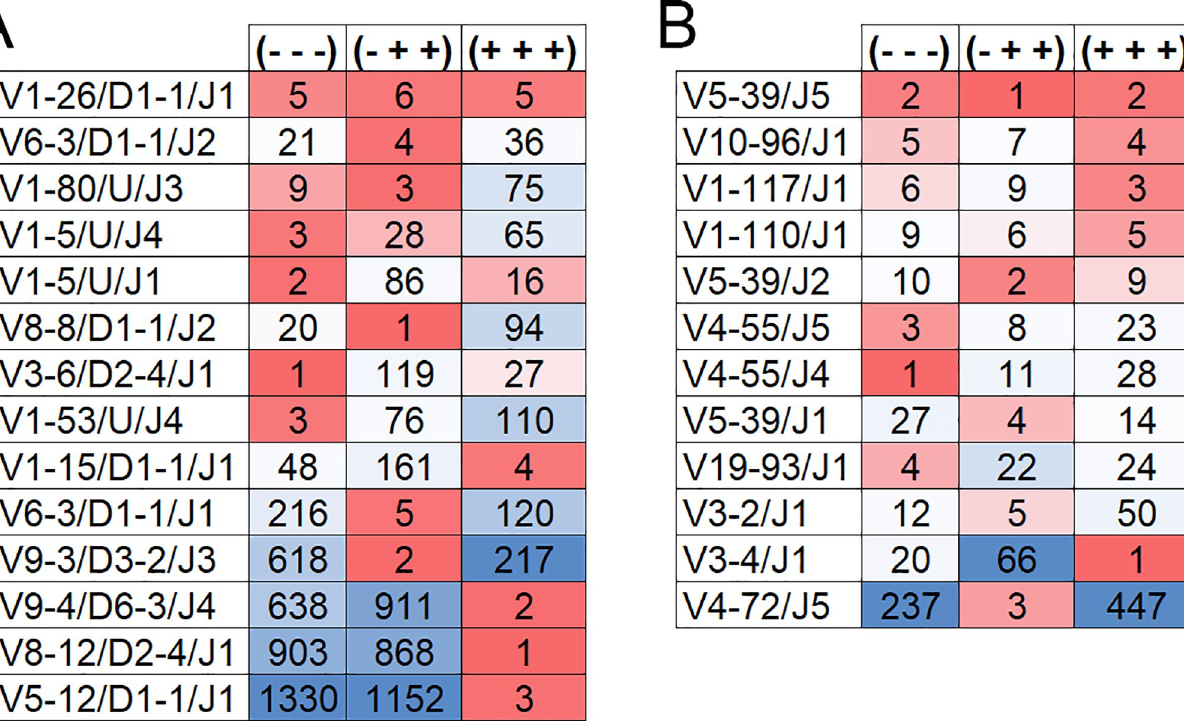
Fig 8. Ranking of High Frequency V-/D-/J-Gene Segment Combinations for Heavy Chain (A) and V-/J-kappa (B) Chain. Mice treated with saline (—), TT+CpG (-++) or AOS+TT+CpG (+++). The top five most common V(D)J combinations (average) per treatment are shown by rank. Heat map frequencies range from dark red reflecting the more common (higher ranking) to blue reflecting the less common (lower ranking).